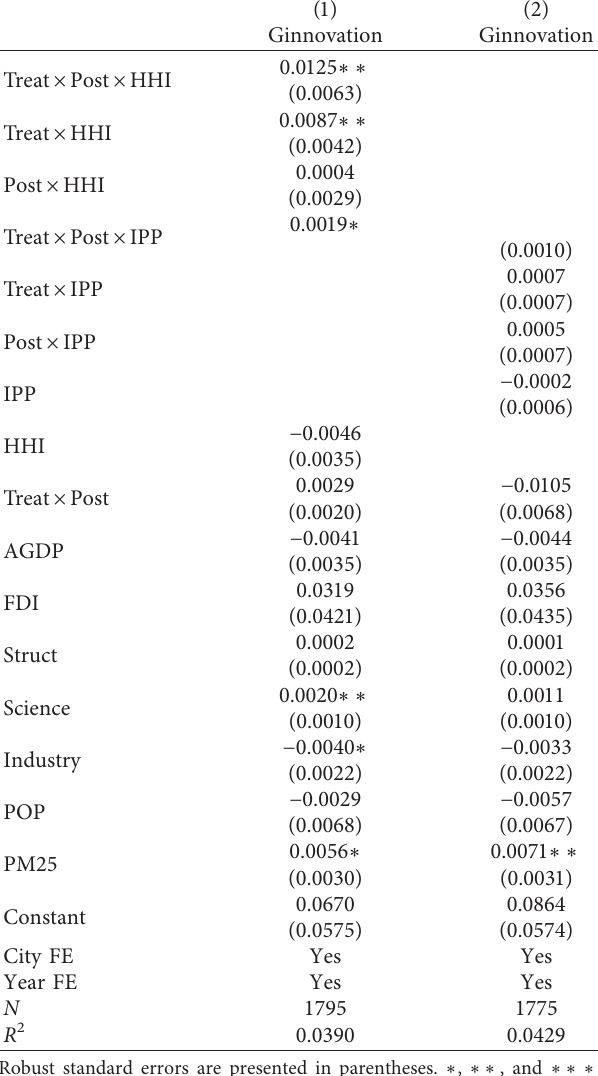
Table 6: Further